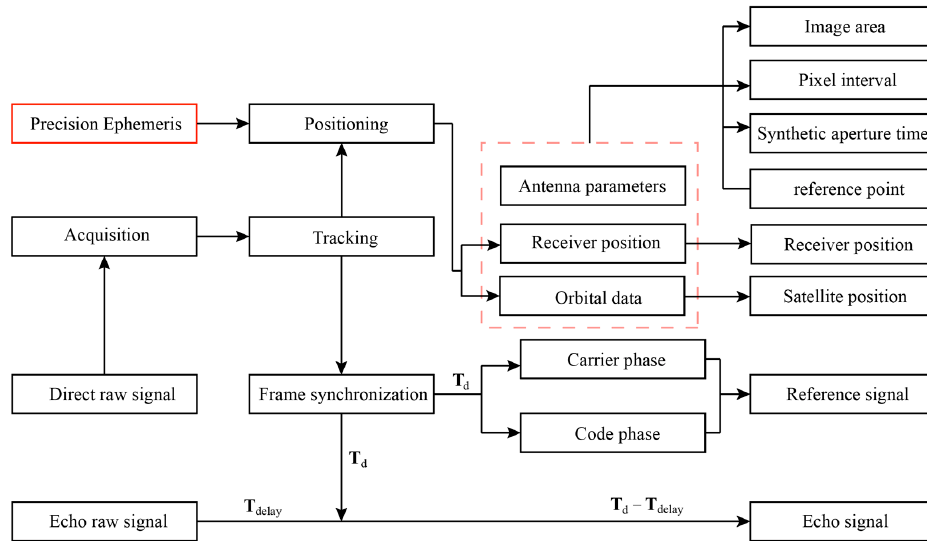
Figure 2. Pre-processing for BPA running on GPU.